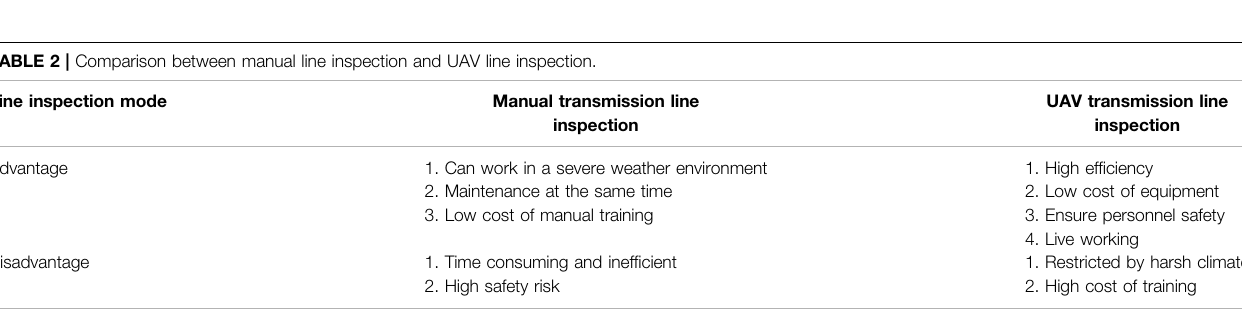
TABLE 2 | Comparison between manual line inspection and UAV line